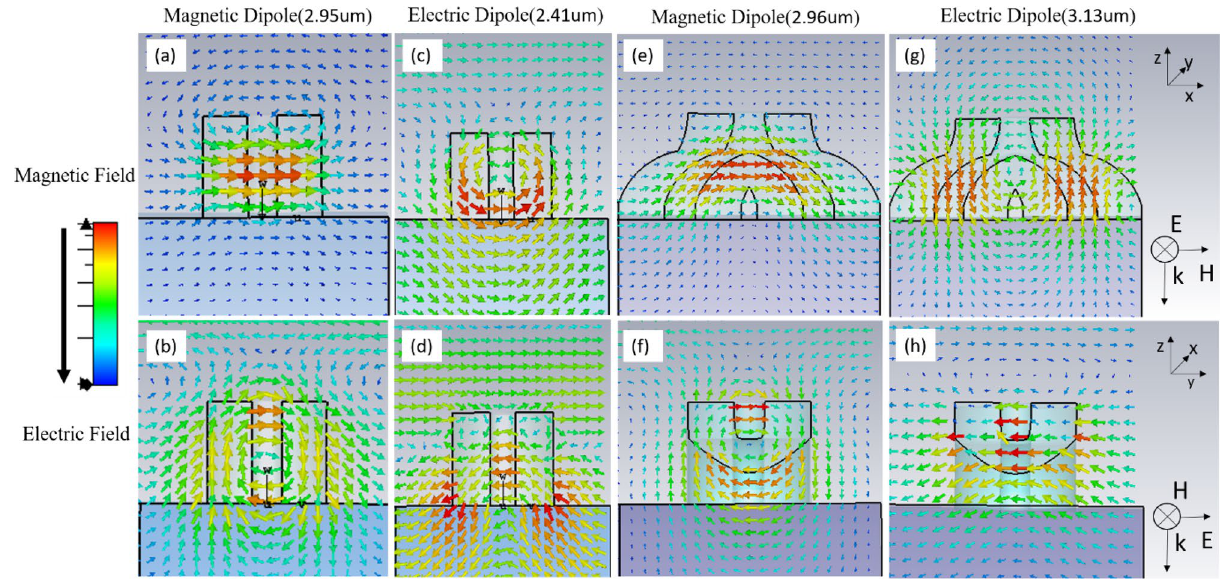
Figure 2. Absolute intensity of magnetic and electric fields represented by arrows, their corresponding dipole modes and wavelengths for conventional cylinder ( a , b , c , d ) and BPC ( e , f , g , h